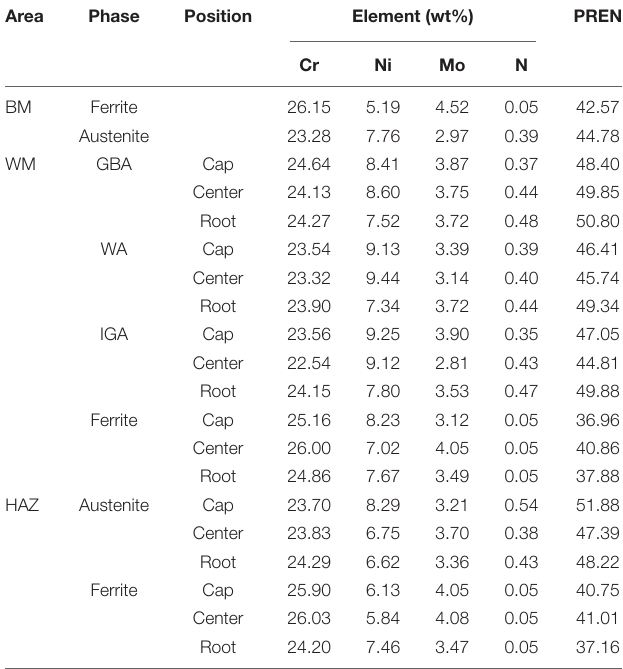
TABLE 3 | Chemical composition and PREN value of different phases in different regions in the GTAW joint with pure Ar shielding. Area